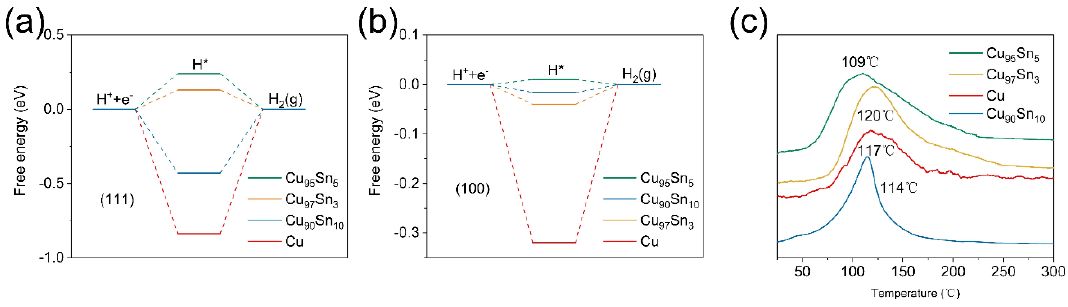
Figure 4. ( a ) Free energies of H* adsorbed on the (111) facet. ( b ) Free energies of H adsorbed on the (100) facet. ( c ) TPD-MS spectra of CO adsorbed on the Cu, Cu 97 Sn 5 , Cu 95 Sn 5 , Cu 90 Sn 10 aerogels.